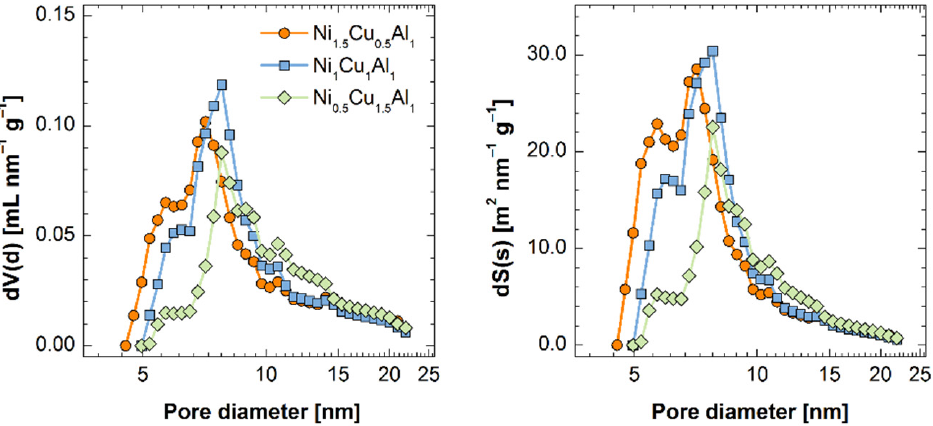
Figure 2. Pore volume ( left ) and surface ( right ) distributions of LDHs calcined at 673 K for 4 h, determined with the DFT model. Table 1. Composition and textural properties of the calcined catalyst precursors.